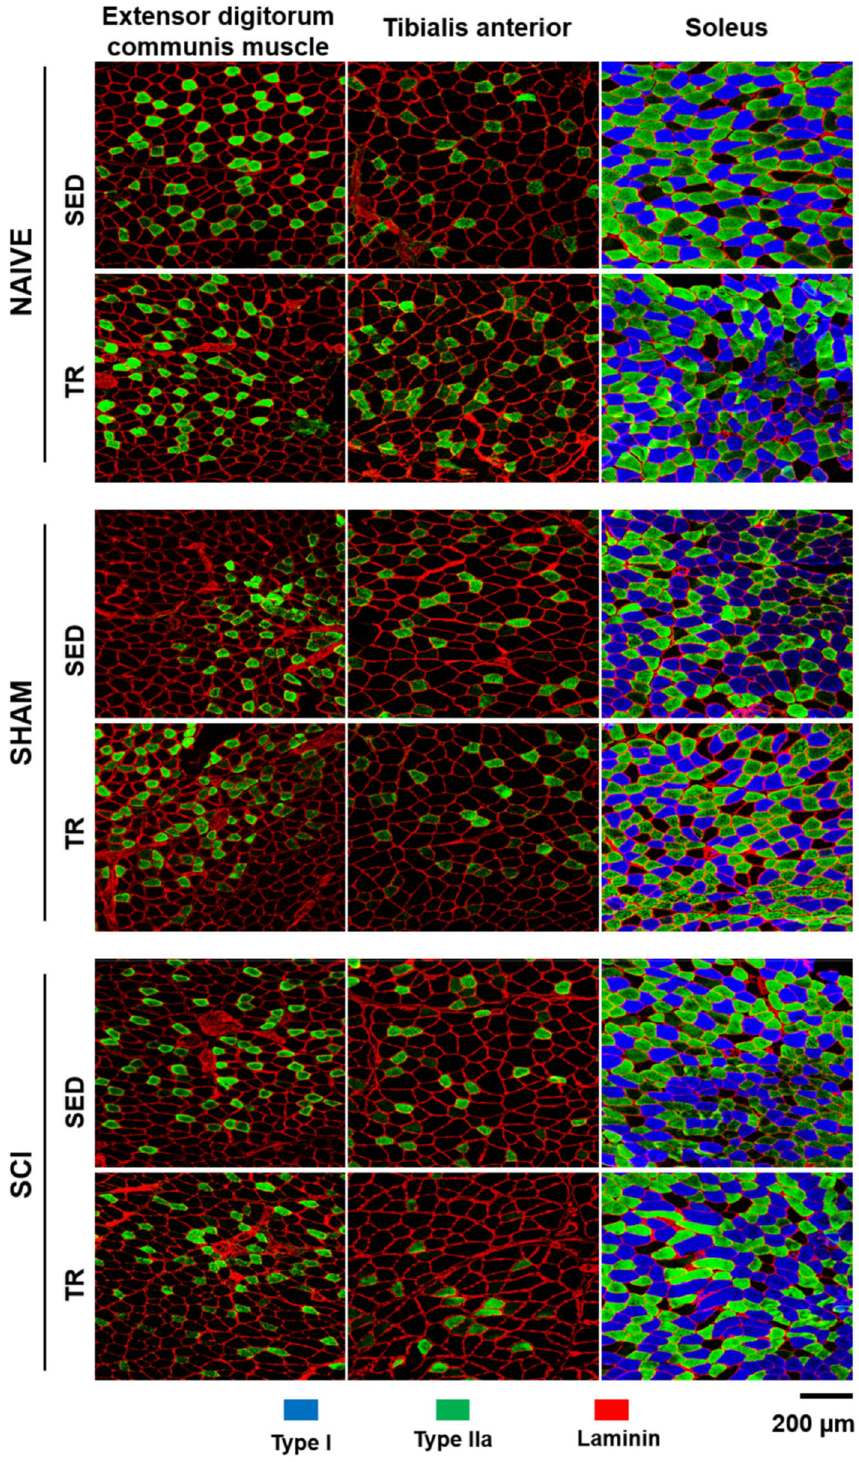
Figure 3. Representative images of fiber type composition in locomotor muscles and analysis of fiber type composition. Extensor digitorum communis (EDC), Tibialis anterior (TA) and Soleus (SOL) cryosections were immunostained to identify Myosin heavy chain (MyHC) isoforms: MyHCSlow (type I in blue), MyHC2A (type IIa in green) co-labeled with an anti-laminin antibody to visualize myofiber boundaries (type IIb/x corresponding to unlabeled fibers). Scale bar = 200